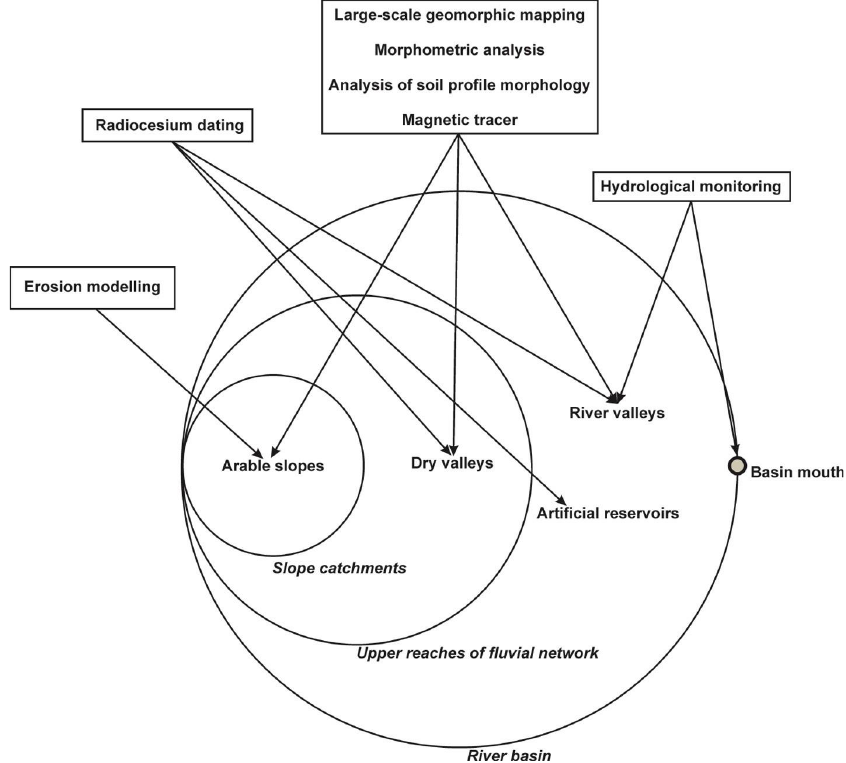
Figure 5. Methods applied in framework of studies within Upa River